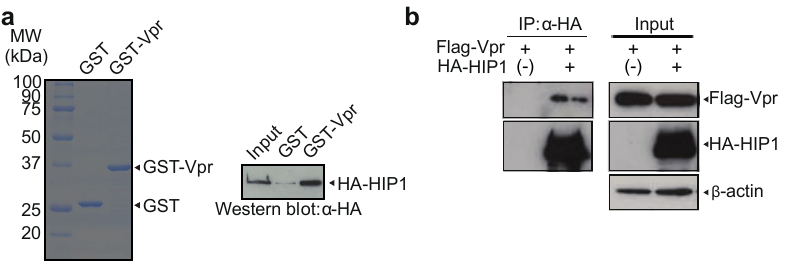
Figure 3. Vpr interacts with HIP1. ( a ) GST and GST-Vpr were resolved by 12% SDS-PAGE and stained with Coomassie Brilliant Blue (CBB) (left). Glutathione-Sepharose beads combined with the GST-Vpr or GST alone were incubated with purified HA-HIP1 protein. The bound fractions and 10% of the input were analyzed by Western blot using the anti-HA mAb (right). The positions of HA-HIP1, GST-Vpr, and GST are indicated. ( b ) 293T cells were co-transfected with pME/FVpr and pCAGGS/HA-HIP1 or control pCAGGS/HA. At 48-h post-transfection, cells were lysed, and the lysates were subjected to immunoprecipitation assays using anti-HA agarose and the HA peptide. The bound fractions and inputs were analyzed by Western blotting using the anti-HA polyclonal Ab, anti-Flag polyclonal Ab, and anti- β -actin mAb.